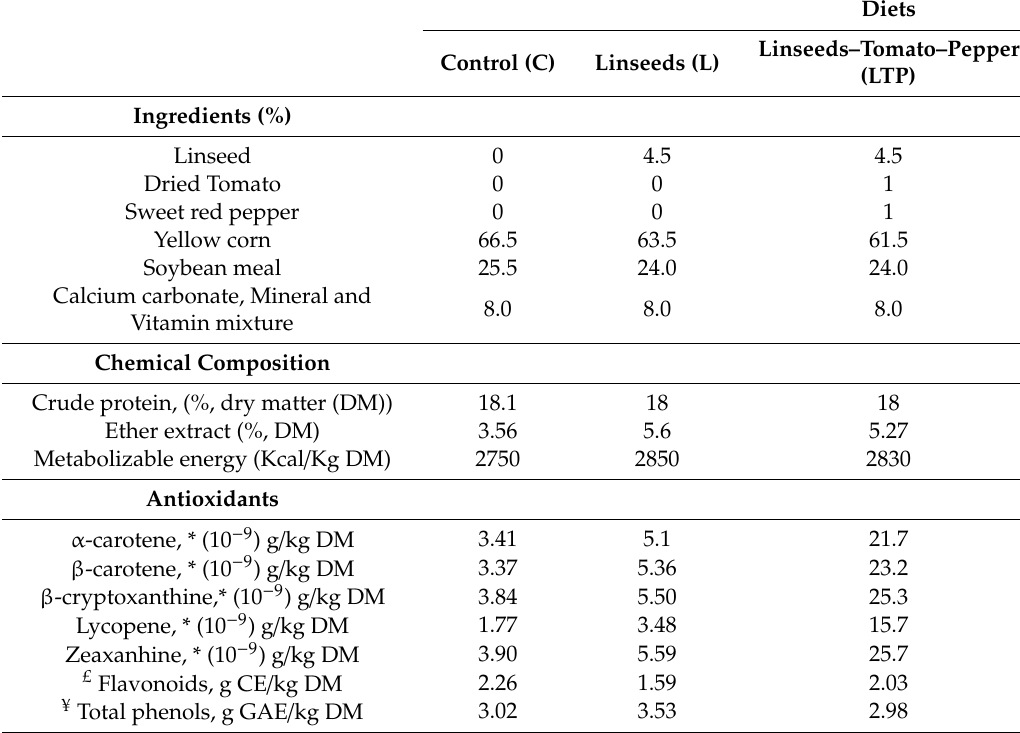
Table 1. Ingredients, chemical and antioxidants composition of the experimental diet (g / Kg)